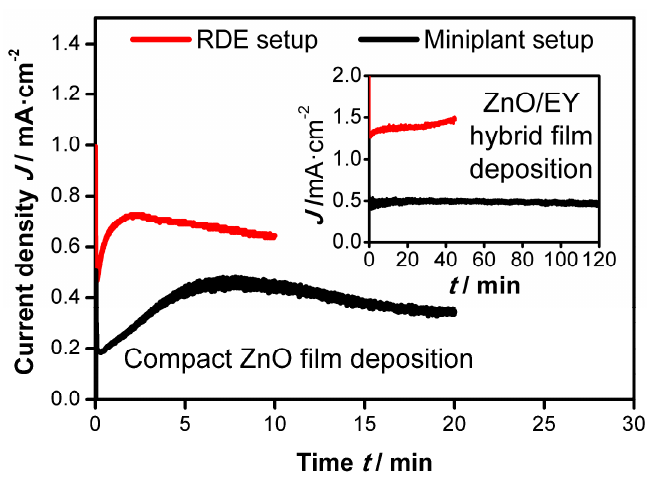
Figure 2. Comparison of current-time behavior between rotating disc electrode (RDE) setup (red lines, at − 0.91 V vs. Ag/AgCl) and miniplant setup (black lines, at − 1.0 V vs. the rest potential vs. Ag/AgCl) during the electrodeposition on FTO-glass substrates: Deposition of compact ZnO films (full scale) and subsequent deposition of ZnO/EY hybrid films (inset).